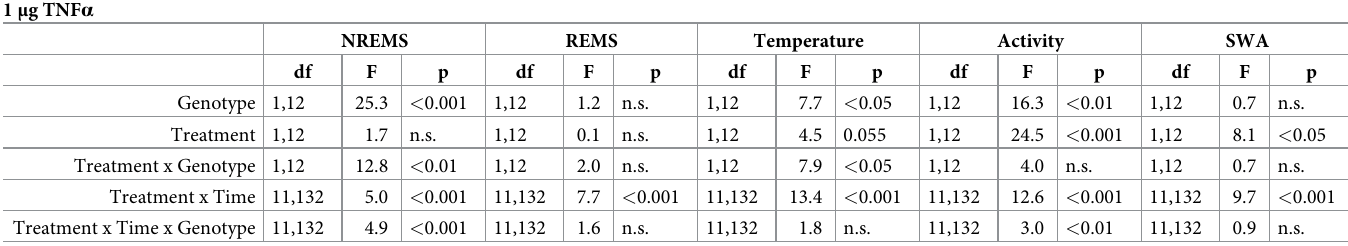
Table 2. Non-rapid-eye movement sleep (NREMS), rapid-eye movement sleep (REMS), body temperature, motor activity and electroencephalographic slow-wave activity (SWA) after 1 μg TNF α administration: Statistical results.